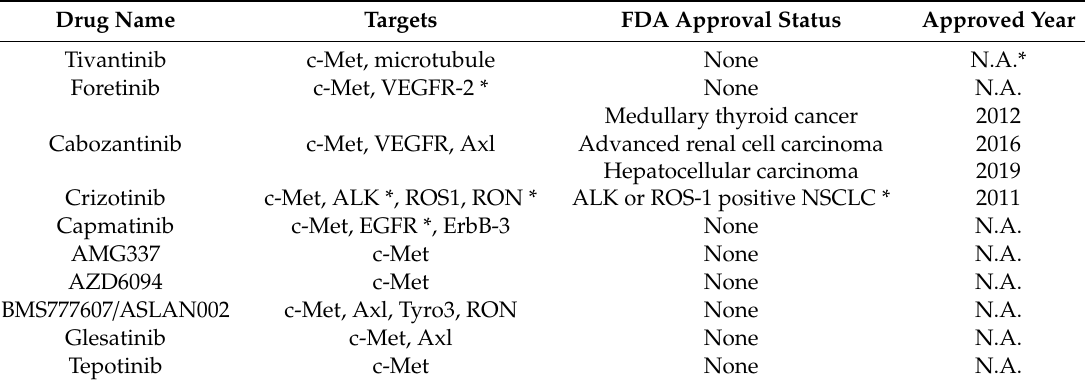
Table 3. Clinical usage of small molecule inhibitors targeting c-Met in cancer